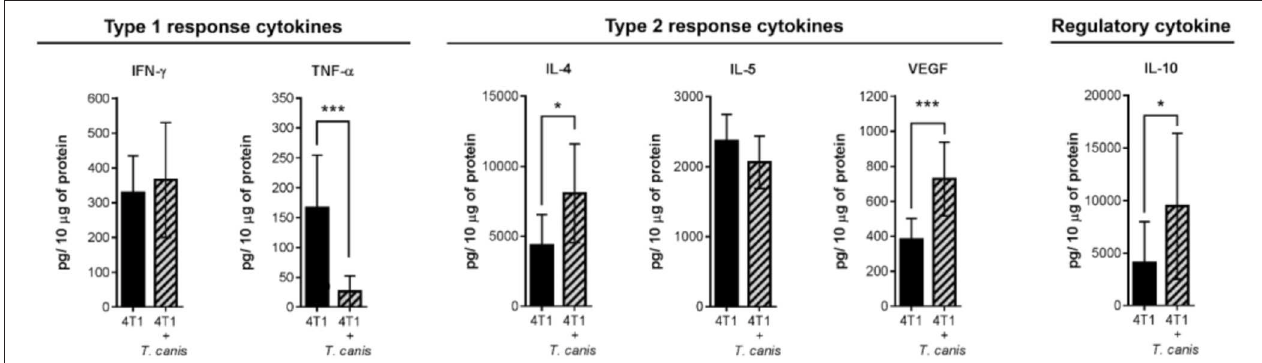
FIGURE 3 | Expression of soluble factors in the tumor microenvironment. Analysis of type 1 (IFN- γ and TNF- α ), type 2 (IL-4, IL-5, and VEGF), and regulatory (IL-10) cytokines. Graphs indicate data from tumor proteins obtained from two independent experiments (4T1, n = 10; 4T1 + T. canis , n = 10). Bars represent the mean ± SD of cytokine levels (pg/10 µ g of tumor protein). Statistical significance was calculated using a t -test (* p ≤ 0.05; *** p ≤